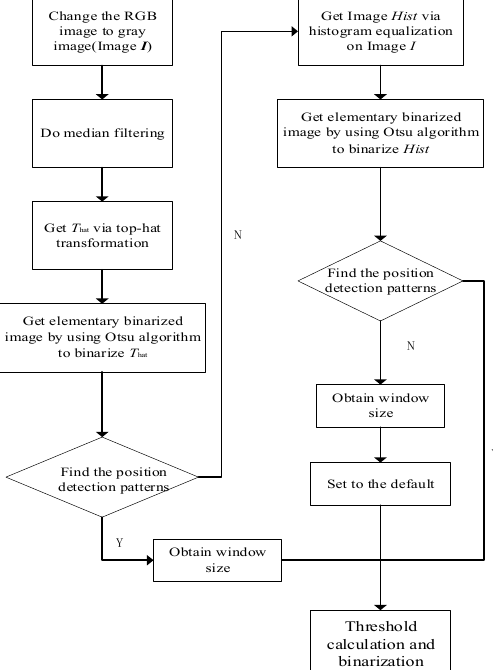
Figure 10. Flowchart of obtaining the window size.